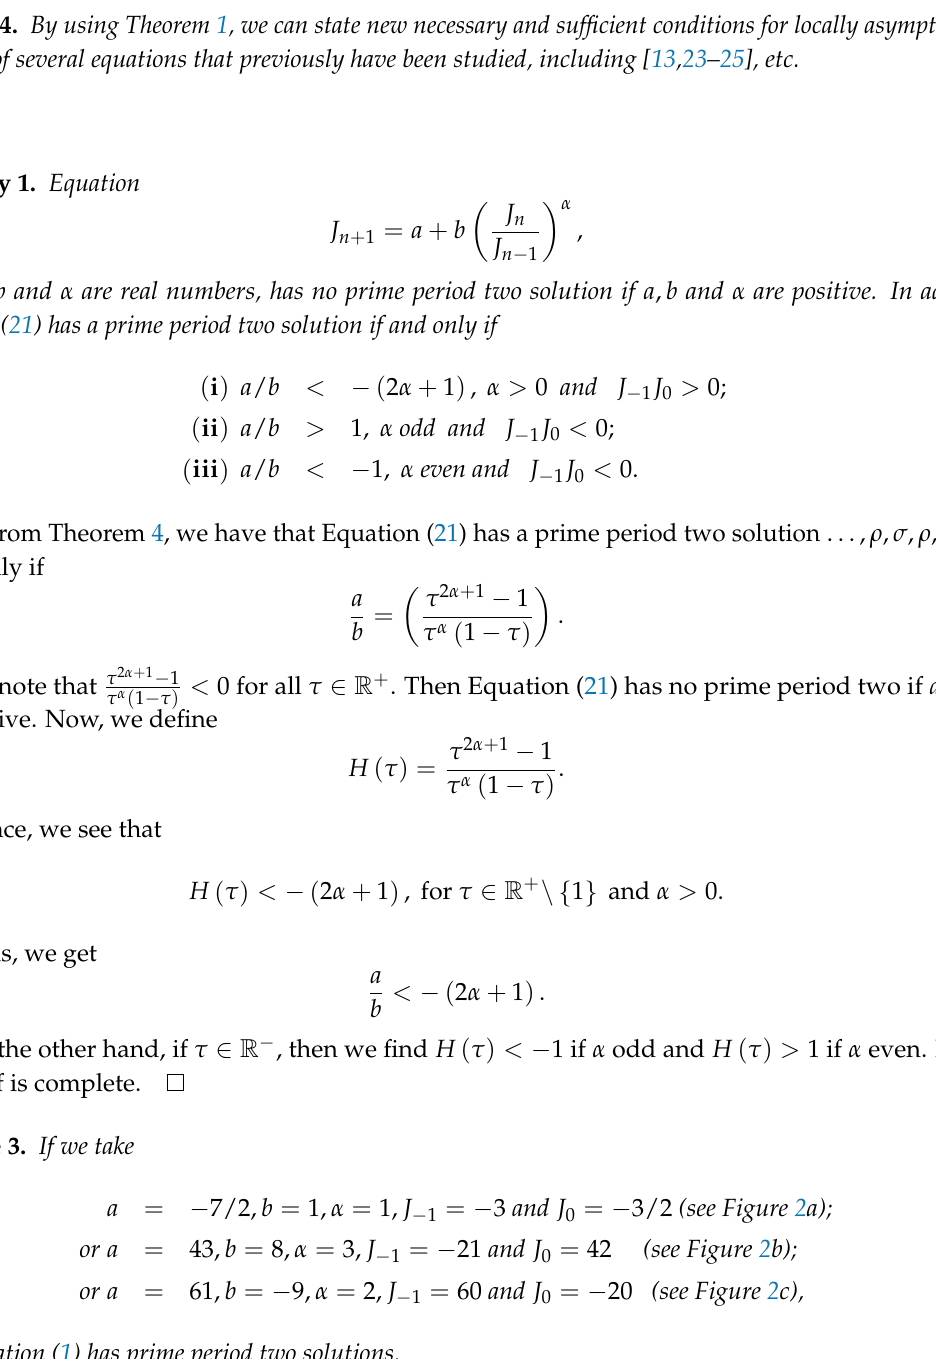
2 Figure 1. The stable solution corresponding to differences Equation